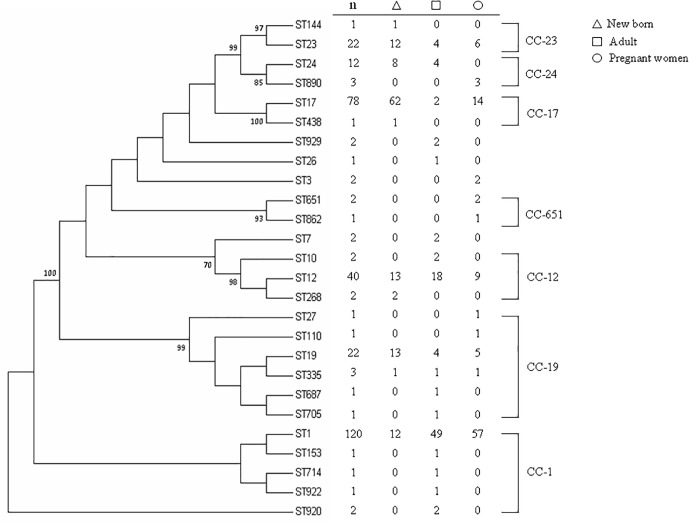
Phylogenetic analysis of MLSTs from 325 GBS strains collected from neonates and adults with invasive disease or colonized pregnant women. The consensus tree was constructed using the neighbor-joining algorithm based on the distance matrix of pair-wise differences between STs. Numbers presented above the branch indicated ST relationships were > 70% bootstrap confidence values based on analysis of 1,000 replicates.